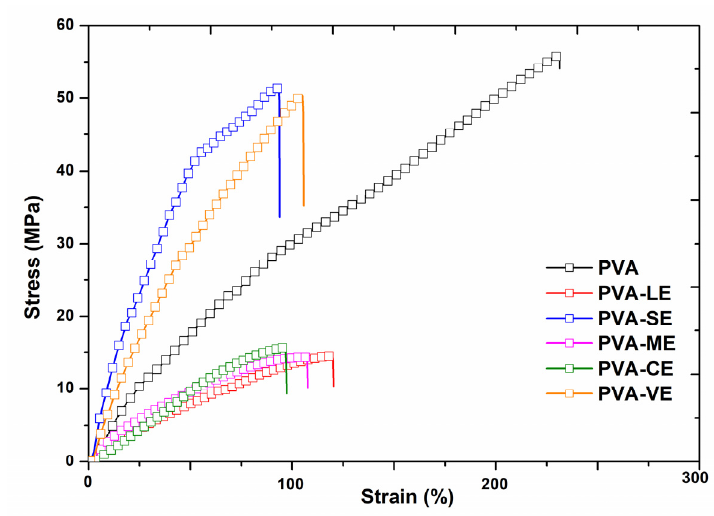
Figure 6. The stress–strain curves of PVA film and PVA loaded with plant extracts. The obtained films with plant extracts recorded the value of the tensile strength